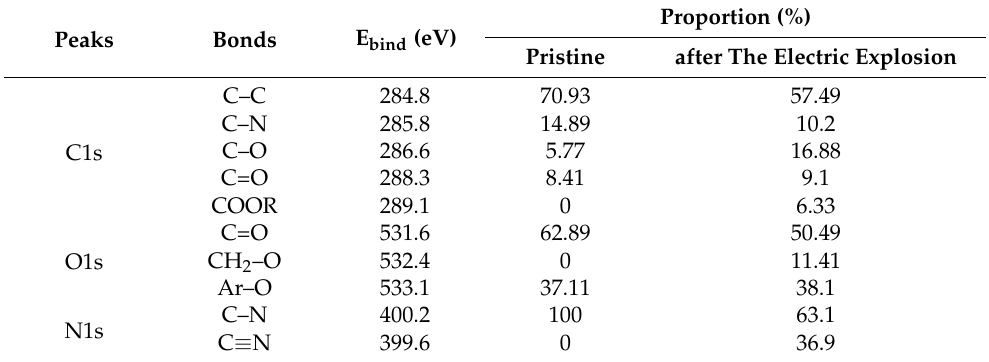
Table 4. The component ratios of pristine and the sample after the electric explosion test.